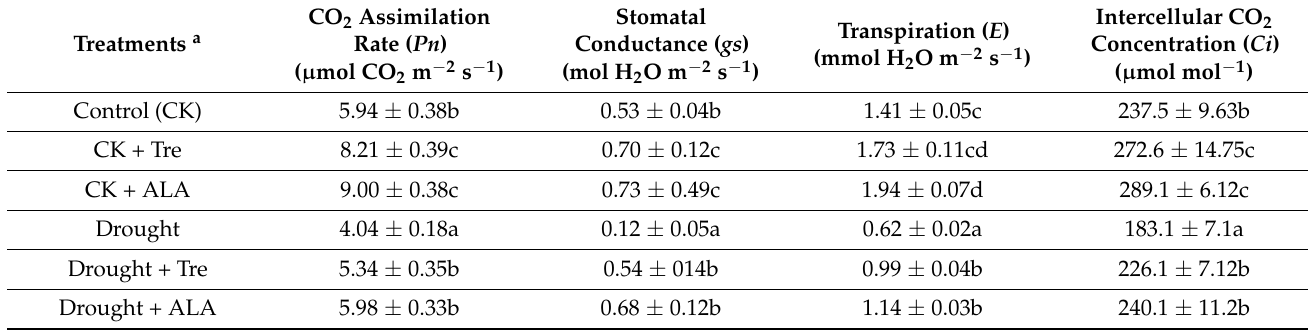
Table 1. Effects of foliar application of 25 mM trehalose (Tre) or 10 mg L − 1 5-aminolevulinic acid (ALA) on leaf gas exchange parameters in Alpinia zerumbet seedlings grown under well-watered (Control, CK) and drought-stress (Drought) conditions. Values are means ± S.E. ( n = 6). Different letters within a column indicate significant differences among means according to LSD test at p <